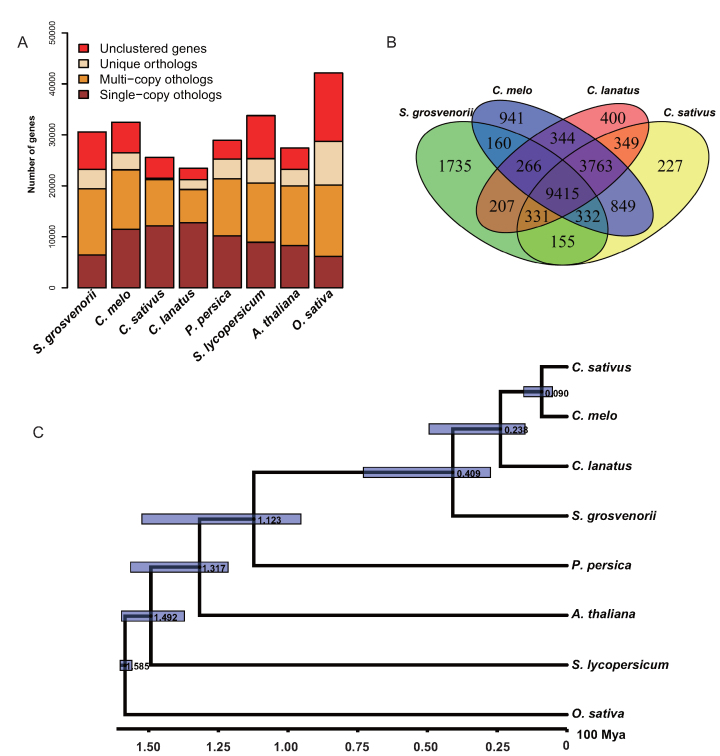
Comparative genome analysis of the S. grosvenorii genome. (A) Orthologue clustering analysis of the protein-coding genes in the S. grosvenorii genome. (B) Venn diagram showing shared and unique gene families among four cucurbit plant species. Numbers represent the number of gene families in unique or shared regions. (C) Phylogenetic tree and divergence time of S. grosvenorii and seven other plant species. The phylogenetic tree was generated from 834 single-copy orthologues using the maximum-likelihood method. The divergence time range is shown in blue blocks. The numbers beside the branching nodes are the predicted divergence time.